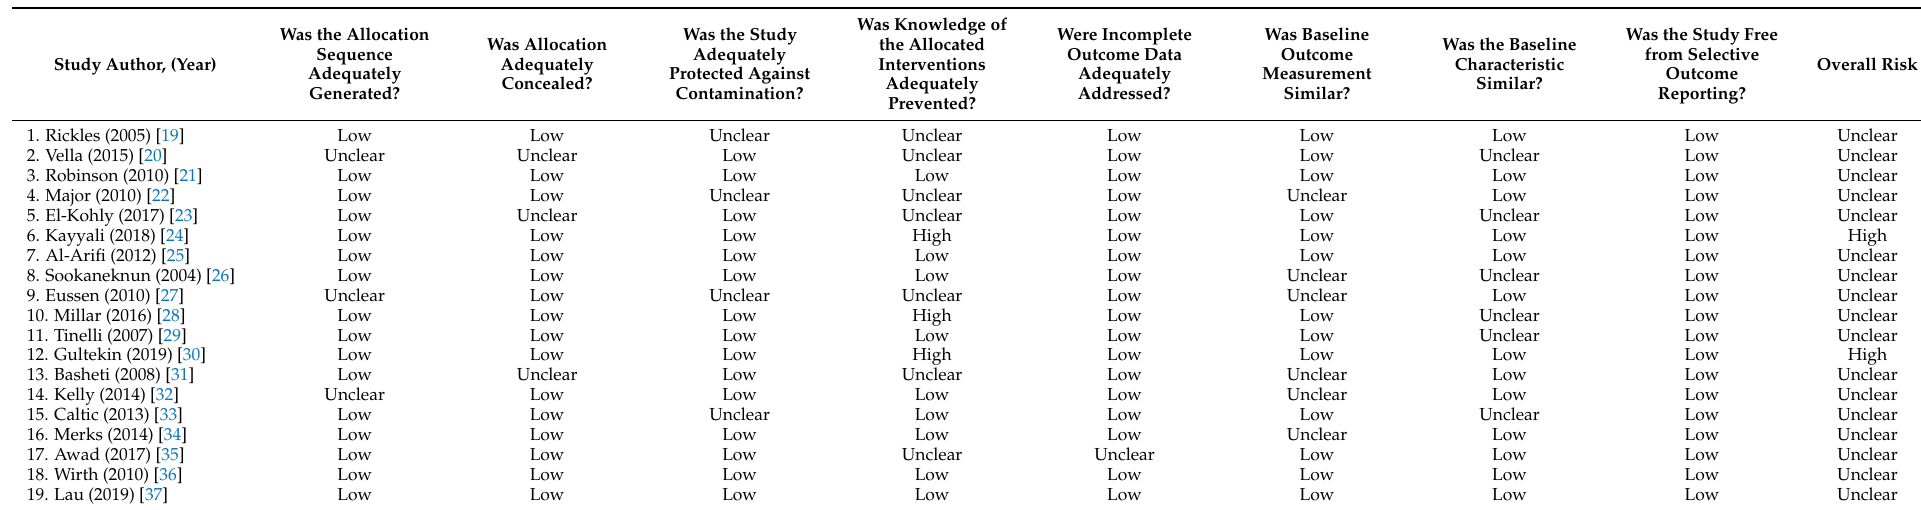
Table 1. Risk of bias of included study categories is based on Effective Practice and Organization of Care